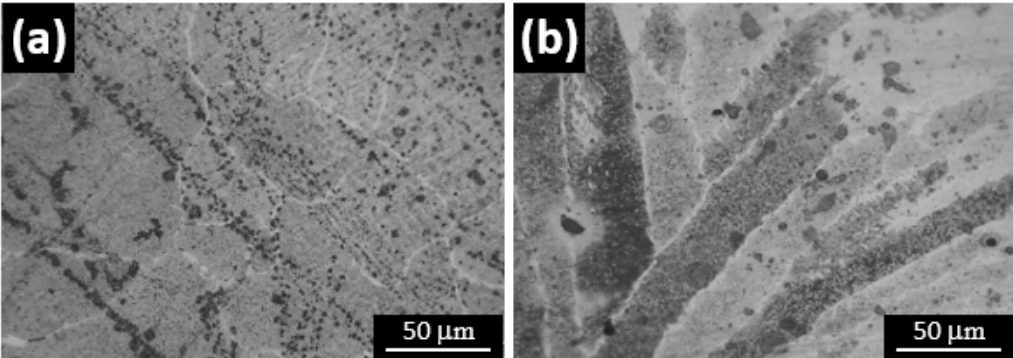
Figure 8. Microstructure of the fusion and heat-affected zones in ( a ) near to the heat-affected zone and ( b ) in the fusion zone.